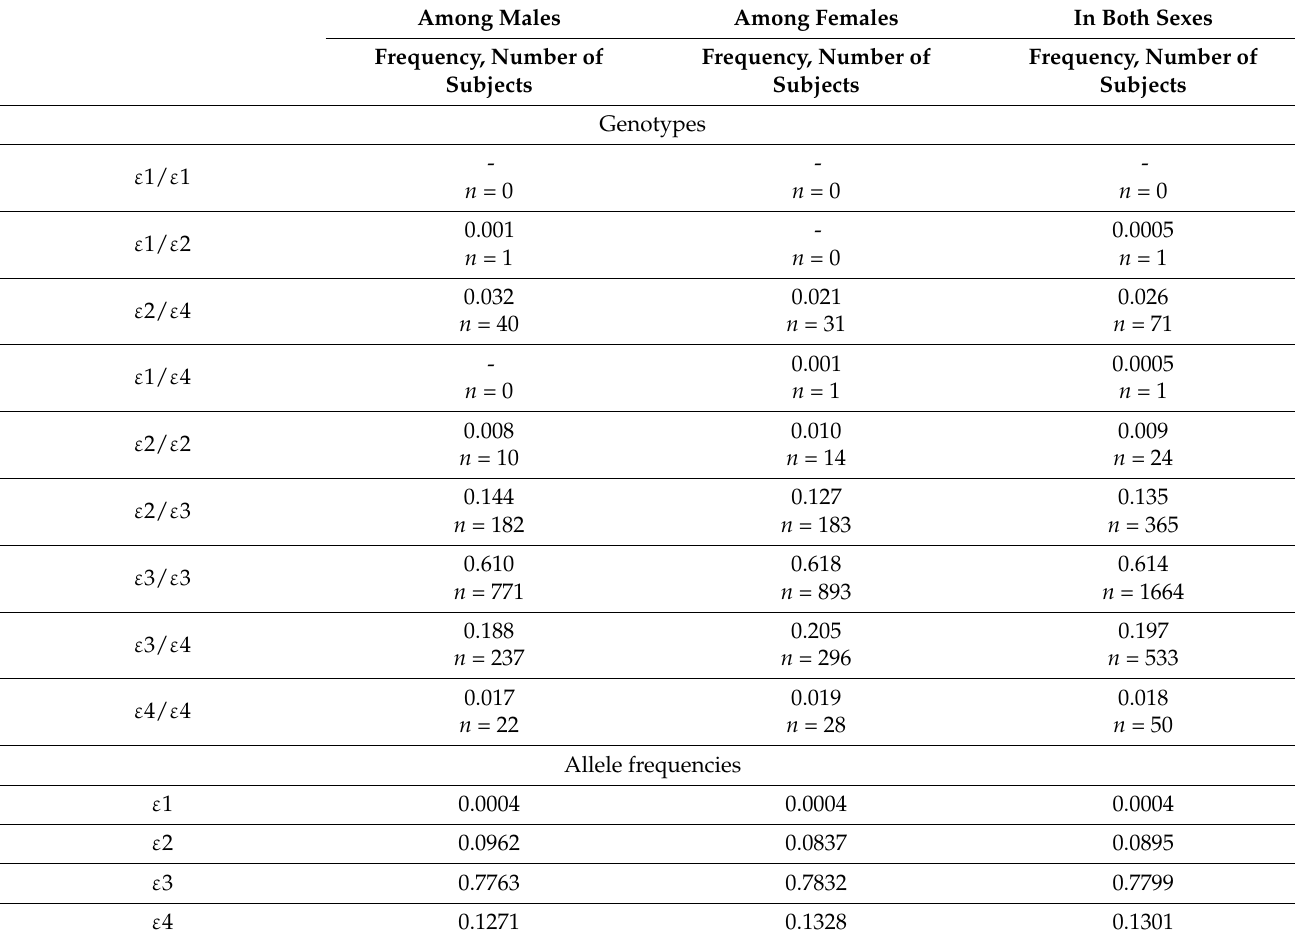
Table 3. Frequencies of alleles and genotypes of rs429358 & rs7412 in the study population. Among Males Among Females In Both Sexes Frequency, Number of Frequency, Number of Frequency, Number of Subjects Subjects Subjects Genotypes - - n =